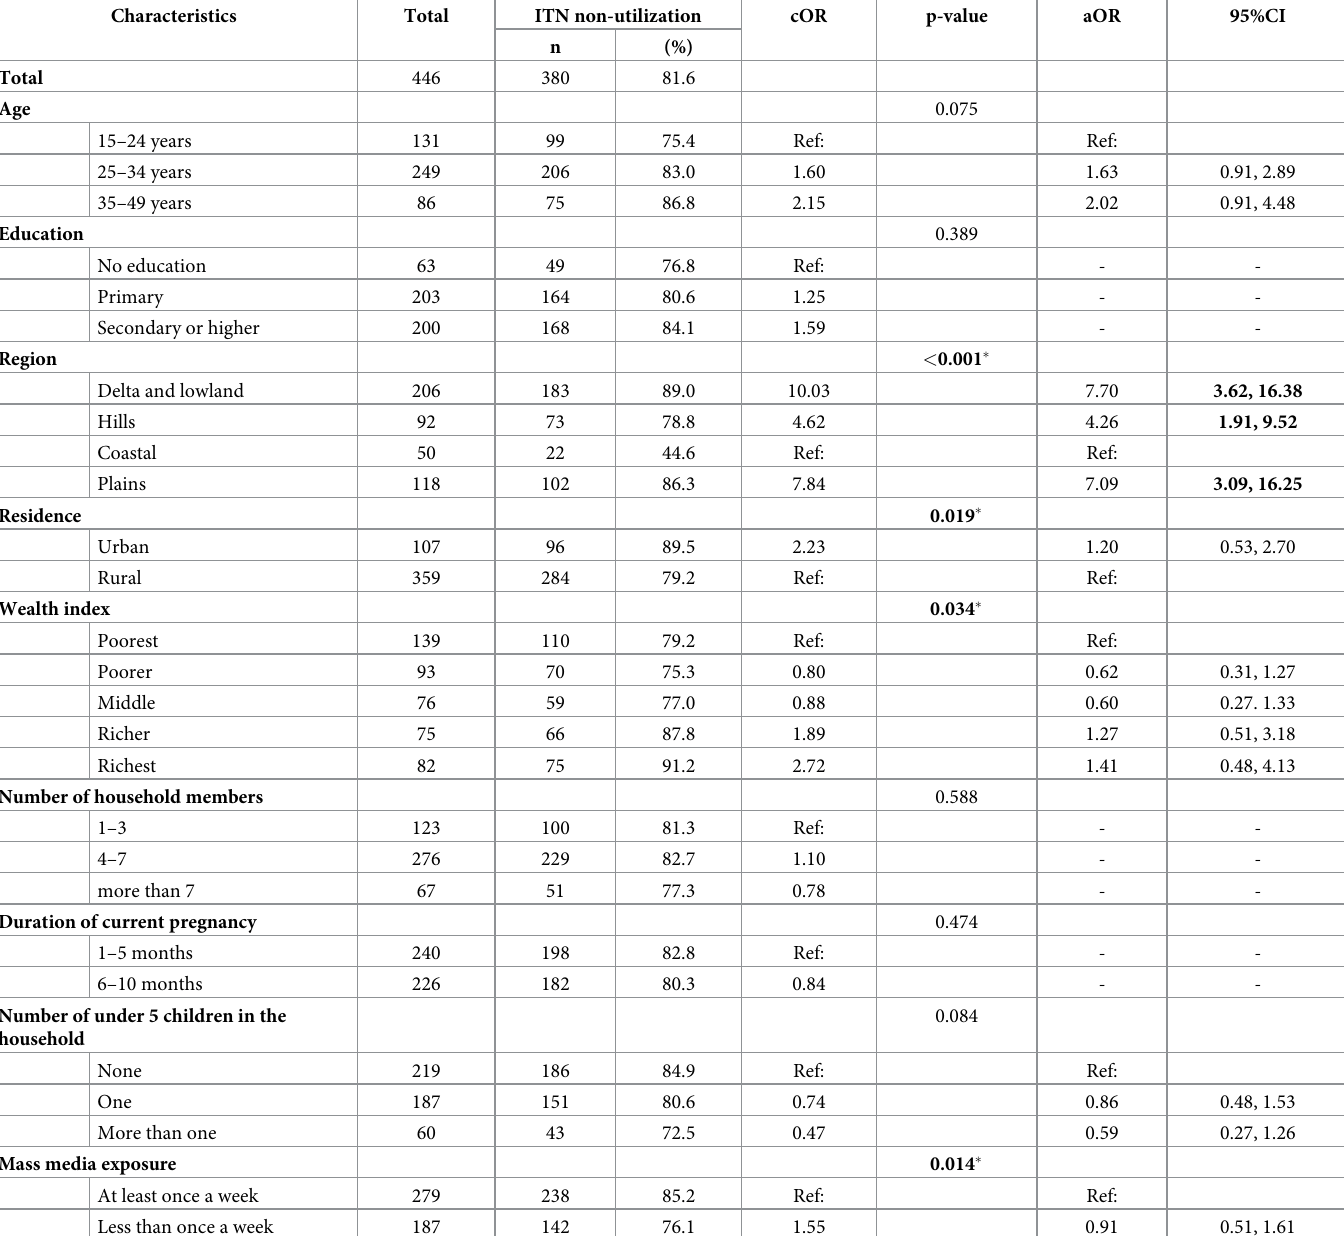
Table 2. Factors associated with non-utilization of insecticide-treated bed nets among currently pregnant women included in the Myanmar Demographic and Health Survey 2015–16 (n = 466).